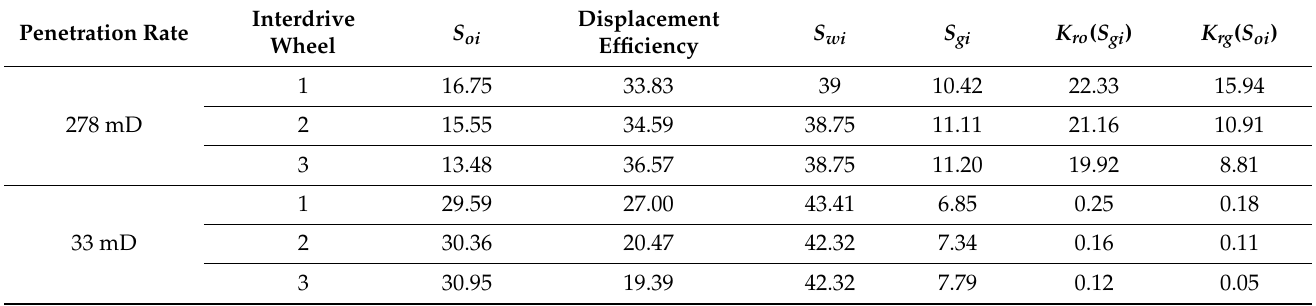
Figure 6. Multiwheel secondary gas–oil interdrive seepage curve of cores No. 5 and 6. (1-g-o-K ro –1 represents turn; g-o represents gas flooding; K ro represents relative permeability of oil phase). Table 5. Characteristic values of multiwheel secondary gas–oil interdrive seepage with different permeability